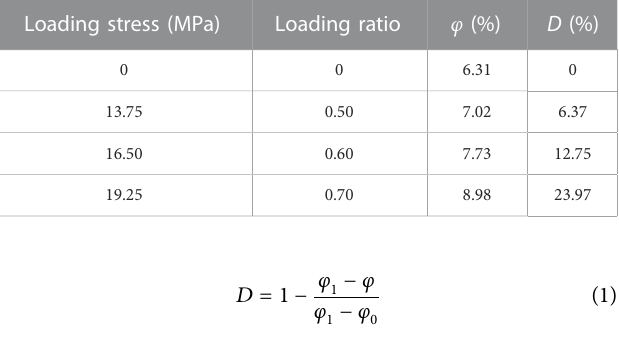
TABLE 2 Initial damage value of sandstone specimen under different loading stress. Loading stress